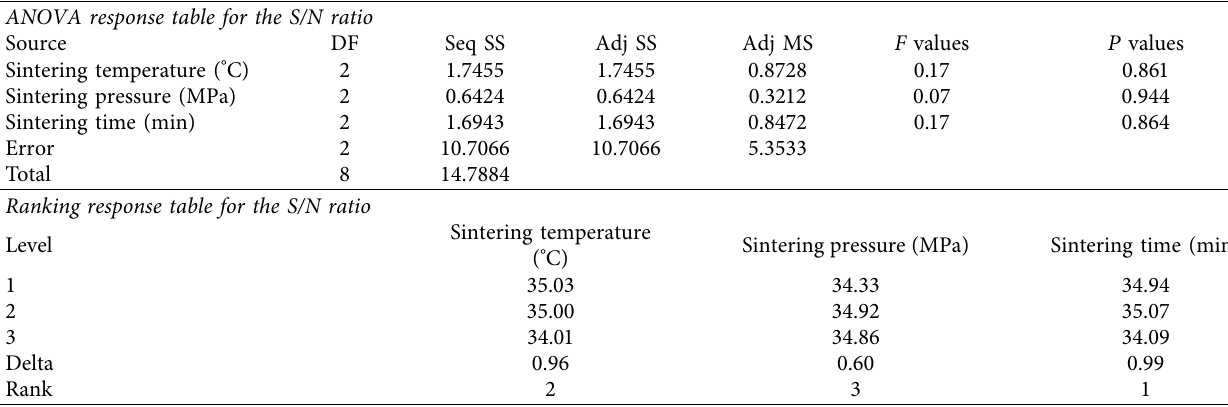
Table 7: ANOVA analysis for the mean S/N ratio of